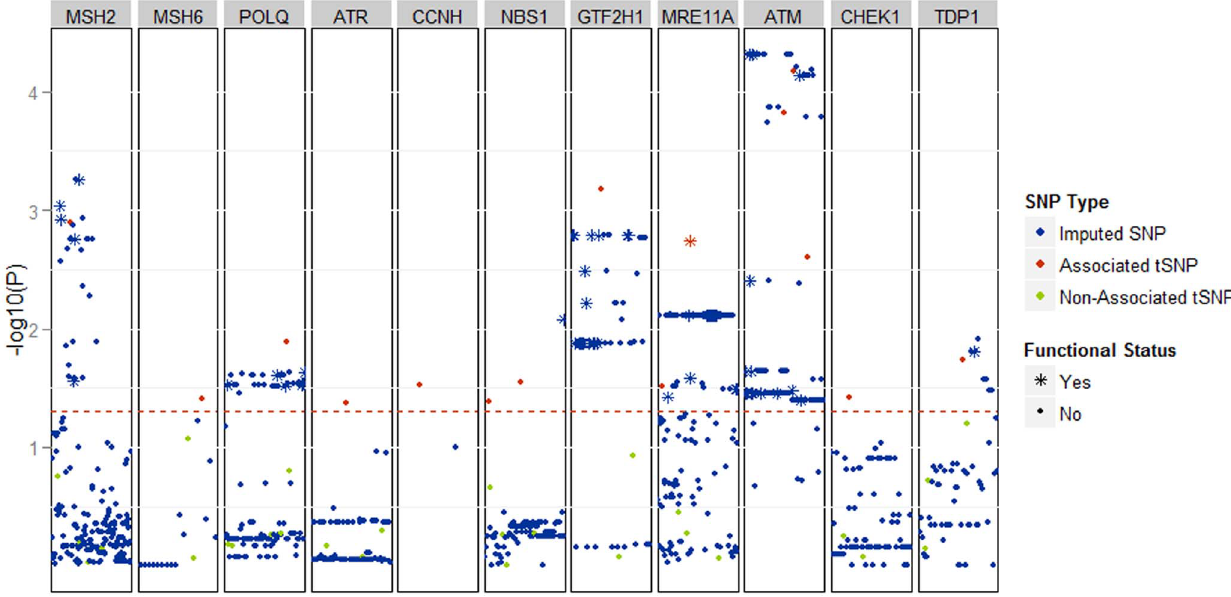
Figure 1. The results of association analysis, displayed as Manhattan plot, after imputation of 28 SNPs genotyped in both stage 1 and 2, which tag 11 DNA repair genes that showed association with NHL risk in our study. The SNPs and genes are ordered by chromosomal position (x-axis). The associations are displayed as –log 10 (p-value) for each SNP. Red dots represent fifteen tagging SNPs that were genotyped in our study and were associated with NHL risk. Green dots represent tagging SNPs that were genotyped in our study and that showed no association with NHL. Blue markers represent SNPs imputed by IMPUTE from 1KG. The red dotted line defines the threshold of p-value , 0.05. * indicates an associated SNP with a putatively functional impact; non-synonymous coding change or SNP mapping in: transcription factor binding site, H3K4Me1 chromatin mark, DNaseI hypersensitivity cluster, 5 9 UTR, 3 9 UTR.